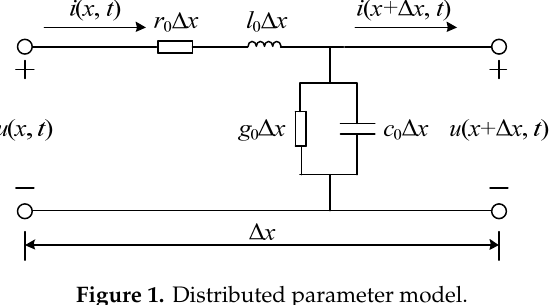
Figure 1. Distributed parameter model.